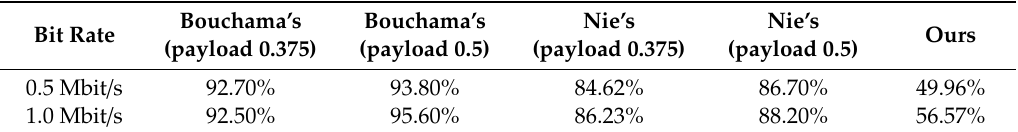
Table 6. Security experiment results.